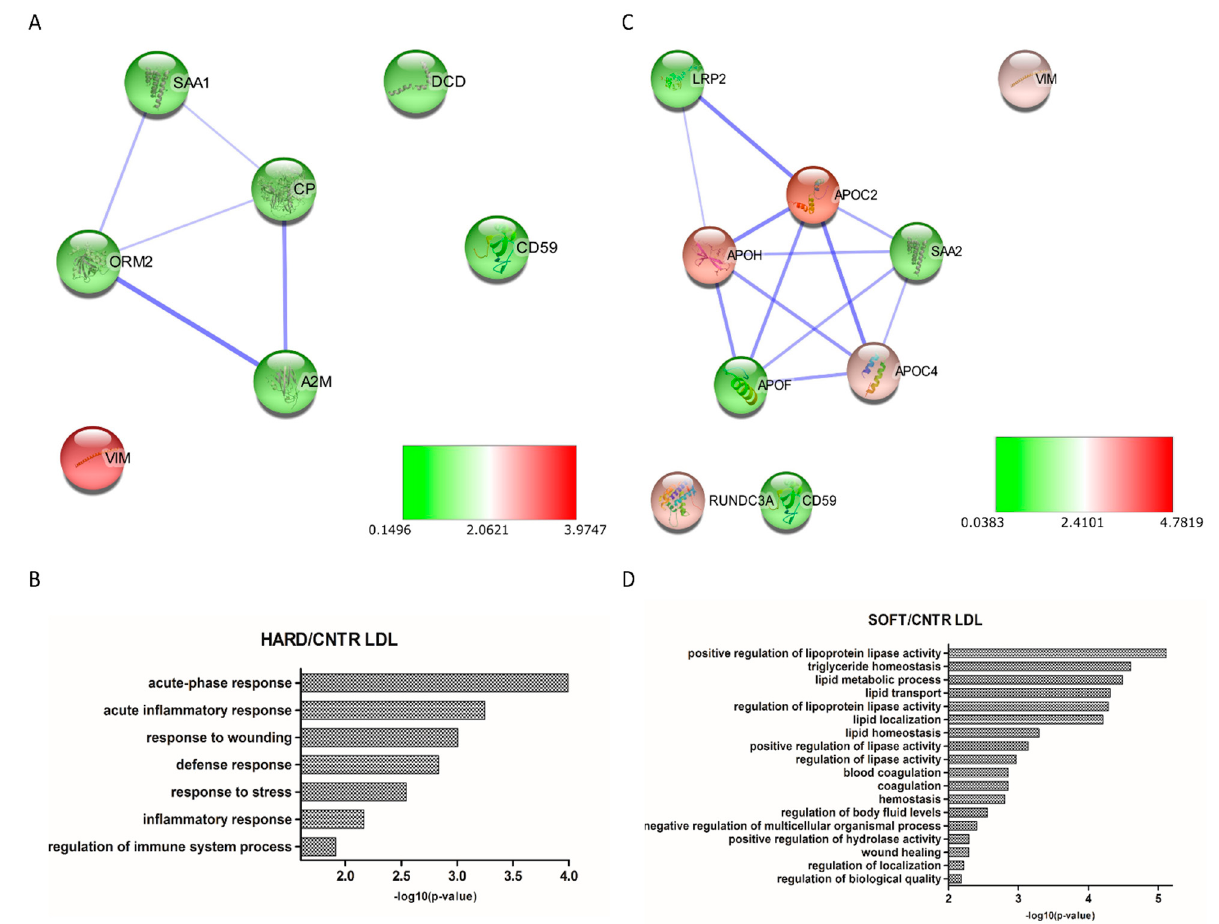
Figure 5. Protein–protein interaction (PPI) network and Gene Ontology (GO) analysis of differentially expressed proteins in LDL “hard” plaques ( A , B , respectively) and LDL “soft” plaques ( C , D , respectively), showing the biological processes in which these proteins are involved. Colors of nodes in PPI networks are representative of FCs compared to controls.